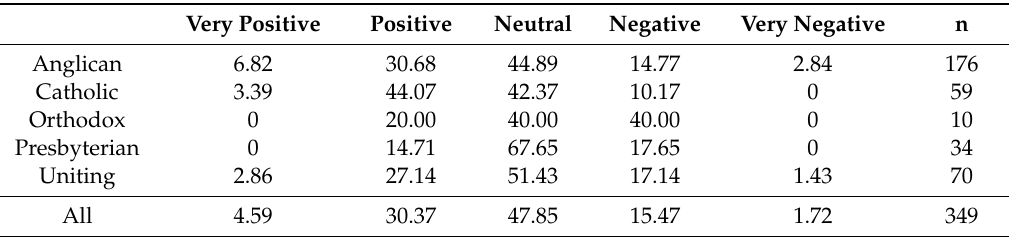
Table 5. Attitudes of the local community towards church bell ringing (in % by denomination), classified into five categories based on free-form responses. Very Positive Positive